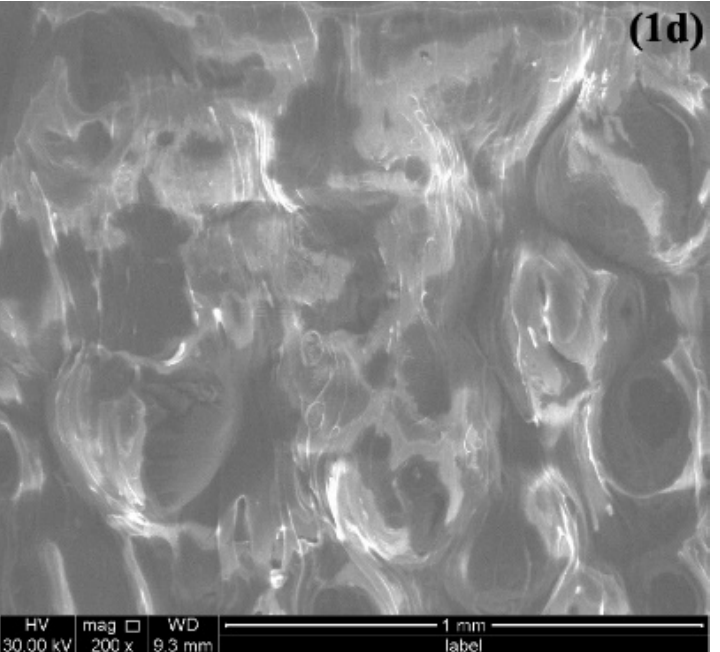
Figure 1. ( a ) FTIR spectroscopy and ( b ) X-ray diffraction patterns ( c ) DSC thermogram of pure resveratrol, phospholipid, physical mixture of resveratrol and phospholipid, resveratrol–phospholipid complex. ( d ) Scanning Electron Microscopic image of resveratrol–phospholipid complex.